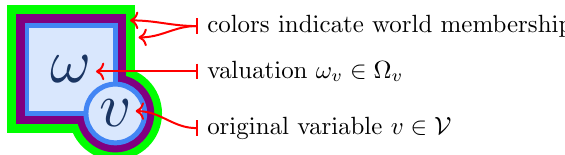
Figure 3: A causal structure G 3 a and the creation of the possible worlds diagram when k µ = k ν = 2 .